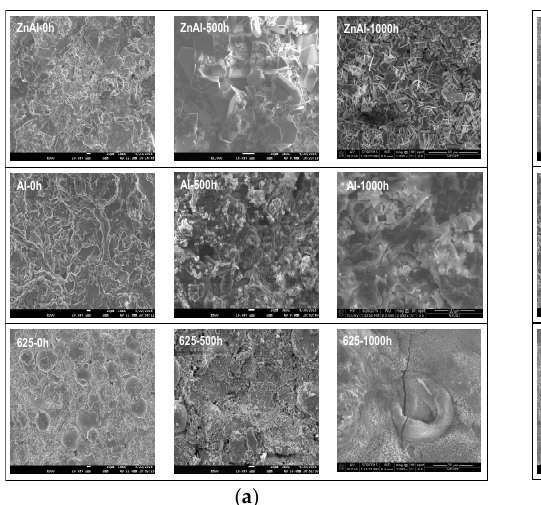
5 of 12 Figure 2. Surfaces after the corrosion test by: ( a ) immersion in 3.5 wt % aqueous NaCl; and ( b ) NaCl 0.025 g/cm 2 deposition in a controlled environment. The deposition of NaCl with the controlled environmental corrosion test shows more severe corrosion behavior than the immersion corrosion. Figure 2b shows the coatings after the corrosion test at 80 °C and 80% RH. The Al coating clearly delaminated after 1000 h of testing. The ZnAl coating became white and covered with delamination. The Inconel 625 coatings became shining spots and brown with an increasing roughness of the surface, but they did not delaminate.